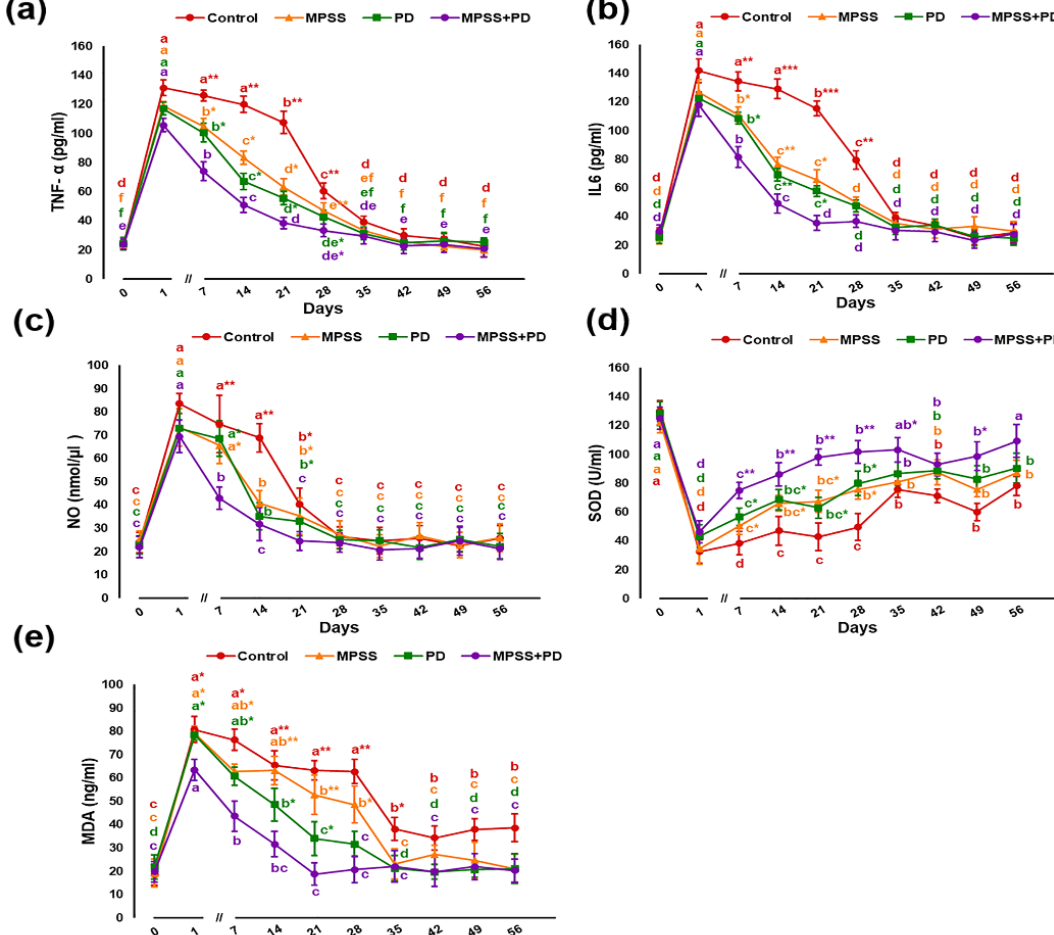
Figure 4. Effect of MPSS, PD, and MPSS+PD treatment on serum levels of pro-inflammatory cytokines and antioxidant status during 8-week study model for SCI. ( a ) Serum TNF- α levels. ( b ) Serum IL-6 levels. ( c ) Serum NO levels. ( d ) Serum SOD activities. ( e ) Serum MDA levels. Data were represented as mean ± SD. Within the same group, different letters indicate a significant difference p < 0.05. At the same time point, * indicates a significant difference ( p < 0.05), ** indicates significant difference ( p < 0.01) and *** indicates significant difference ( p < 0.001). Data from different groups were compared to normal preoperative values at 0 day